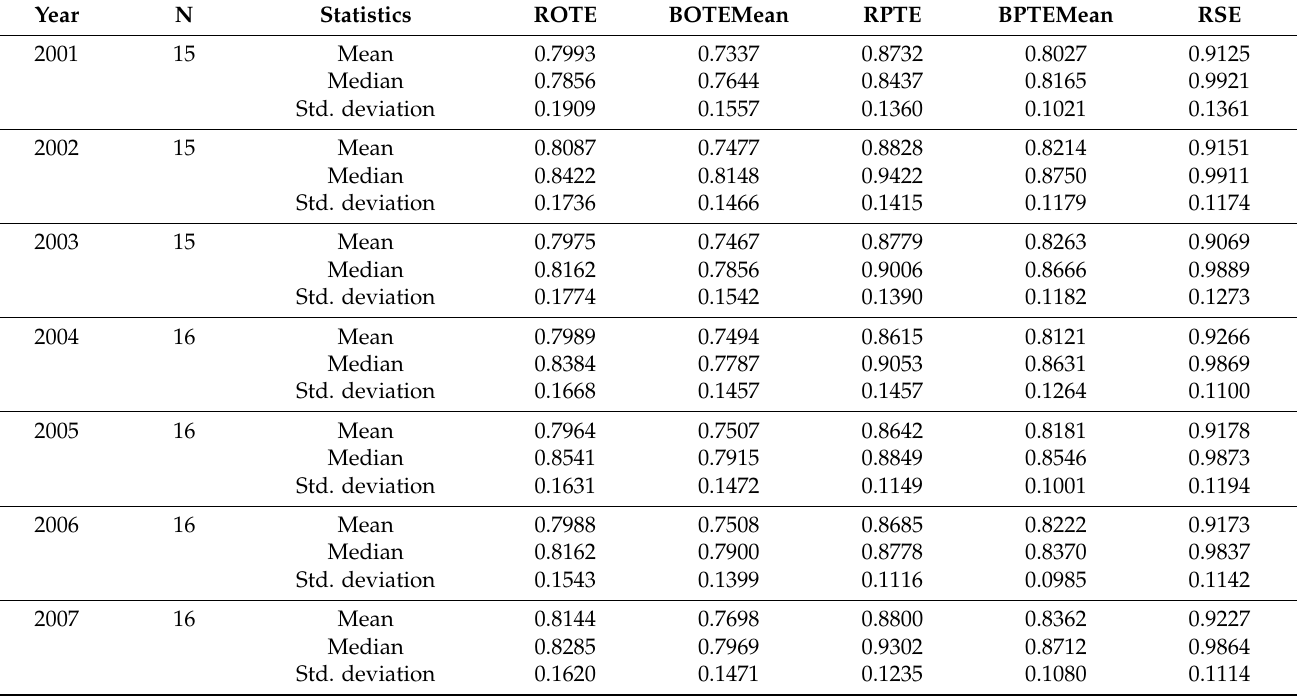
Table 5. Statistics pertaining to the annual efficiency scores of the power-generating